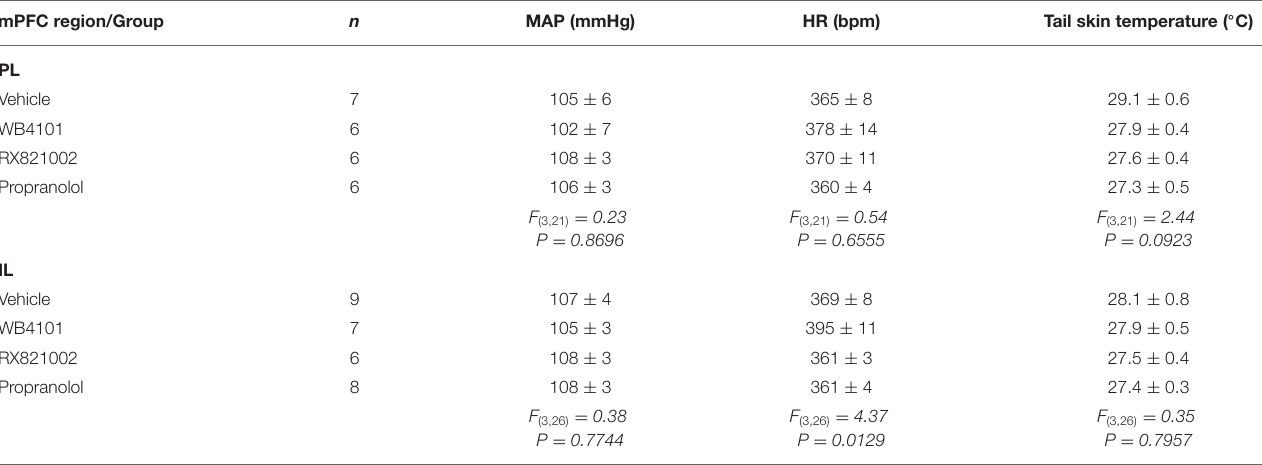
TABLE 1 | Basal parameters (i.e., pre-stress values) of the mean arterial pressure (MAP), heart rate (HR), and the tail skin temperature after pharmacological treatment of either the prelimbic (PL) or infralimbic (IL) cortex with the selective α 1 -adrenoceptor antagonist WB4101 (10 nmol/100 nl), the selective α 2 -adrenoceptor antagonist RX821002 (10 nmol/100 nl), the β -adrenoceptor antagonist propranolol (10 nmol/100 nl), or vehicle (10 nmol/100